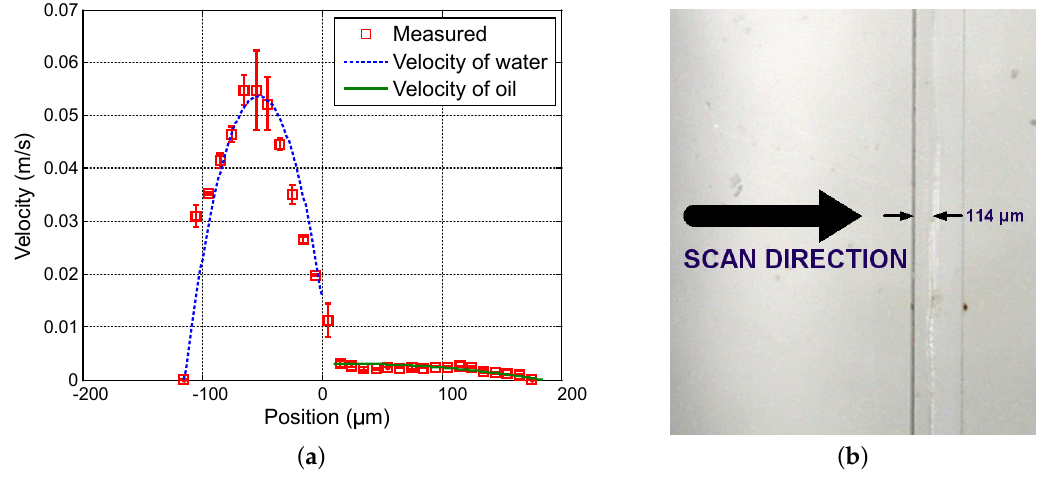
Figure 7. Experimental results for Q water = 20 µL · min − 1 and Q oil = 1.5 µL · min − 1 . ( a ) Measured profile (squares) and theoretical profile for water (dashed line) and for oil (solid line); and ( b ) reference image of the main channel with indication of the interface